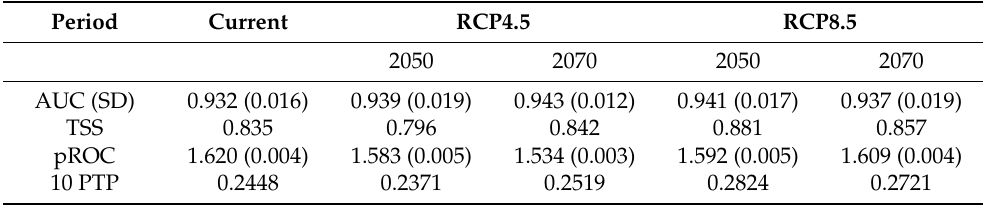
Table 2. Model evaluation statistics of the mean AUC, TSS and pROC. Standard deviation in parentheses. Period